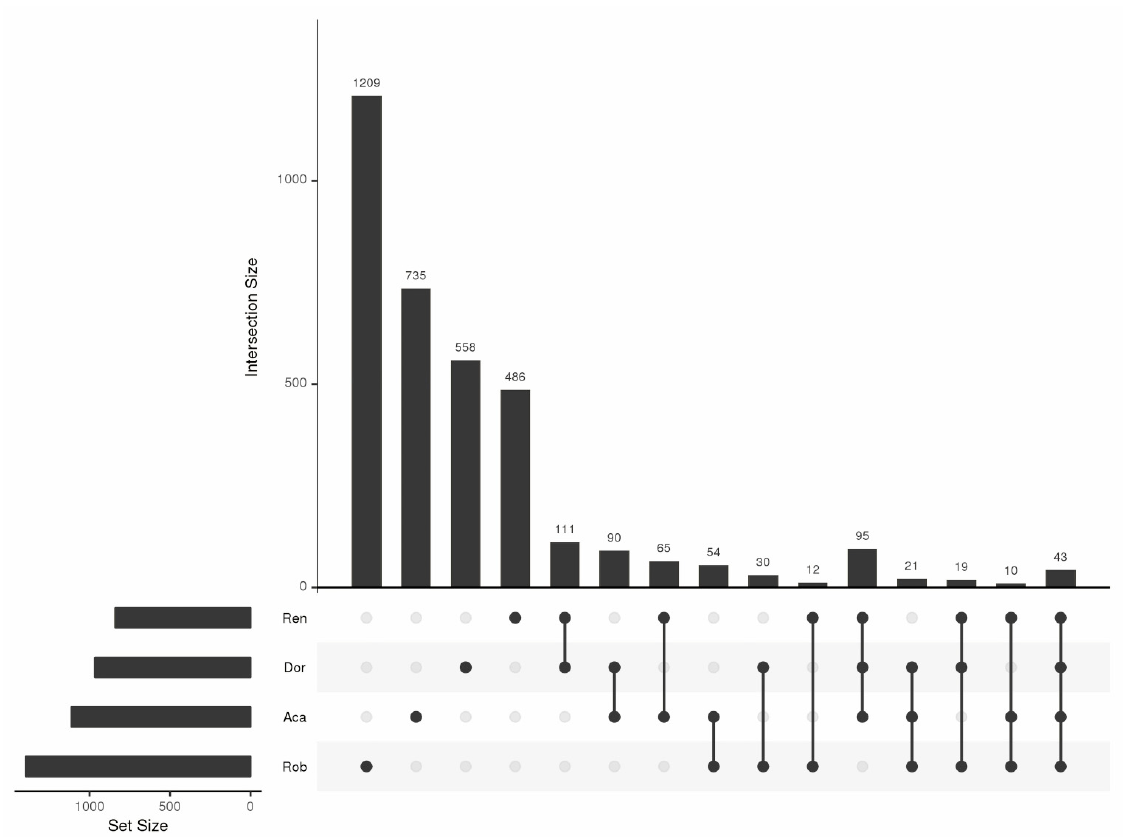
Nature Reserve of Hainan in China. The dots indicated the outliers.